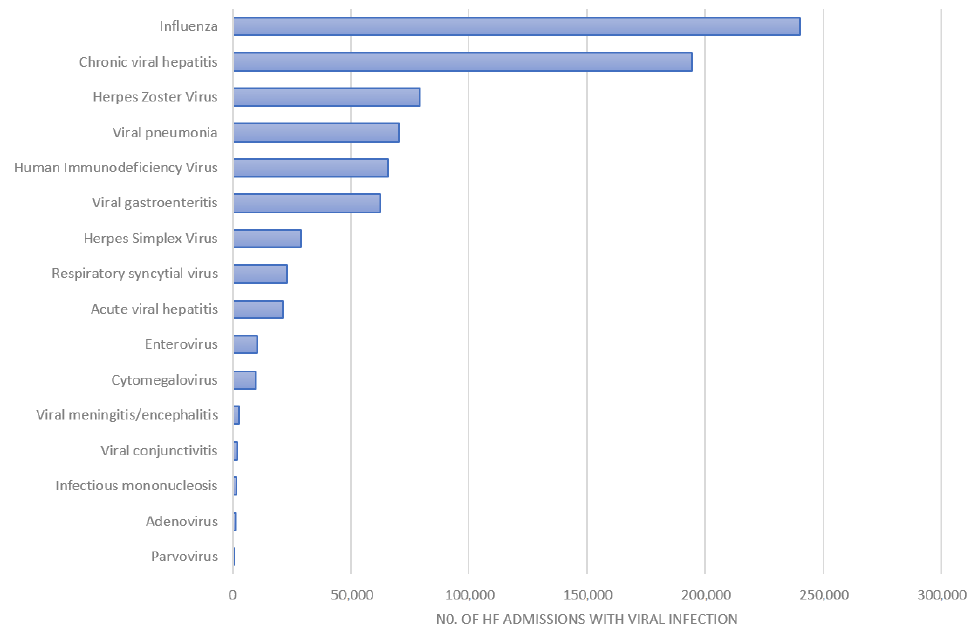
Figure 1. Admissions for viral infections among records with a diagnosis of heart failure. 3.4. In ‐ Hospital Mortality Rate and Adjusted Odds of Mortality for Specific Viral Infections